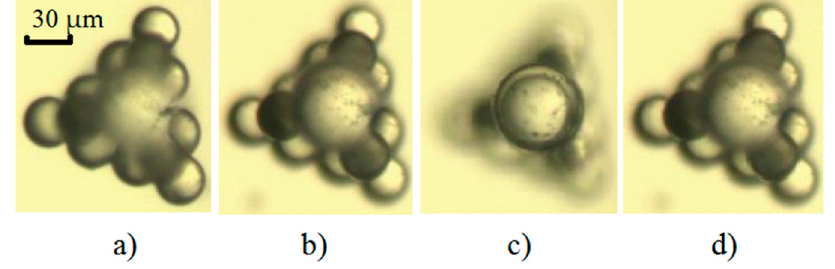
Figure 7. 3D micro-object—a trident base with a glass sphere on the top: ( a ) the bottom layer; ( b ) the second layer; ( c ) the top layer; ( d ) the complete three-layered 3D construction.